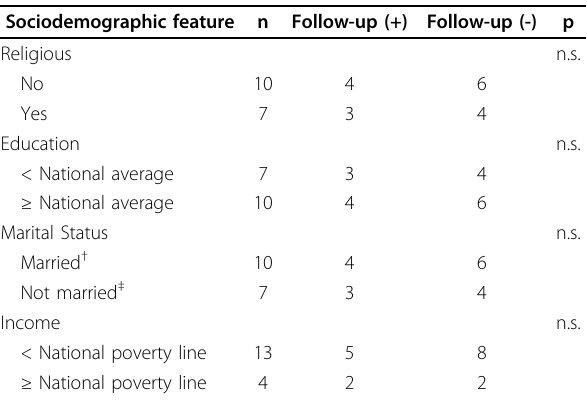
Table 4 Socio-demographic correlates of adherence to tumor surveillance